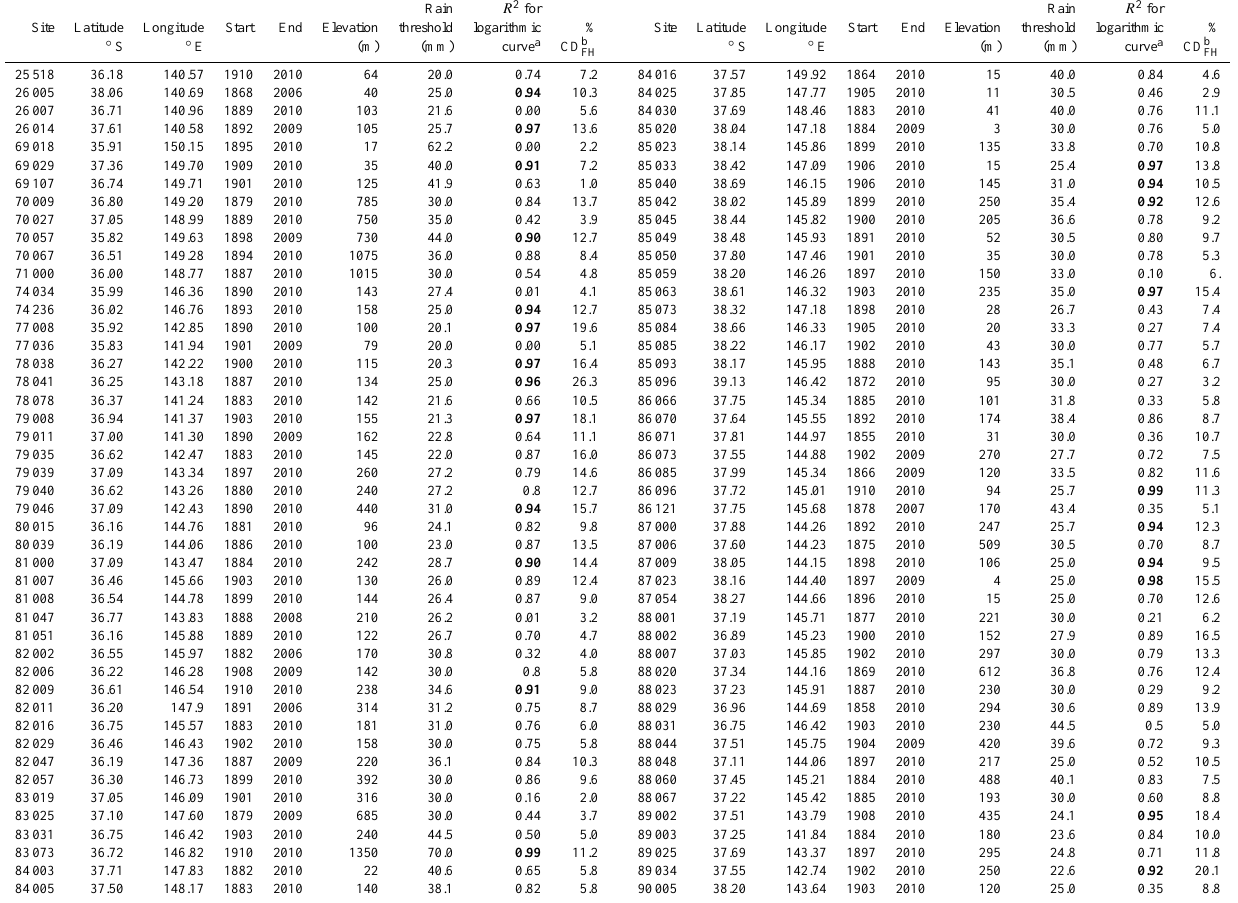
Table 2. Southeast group of rainfall